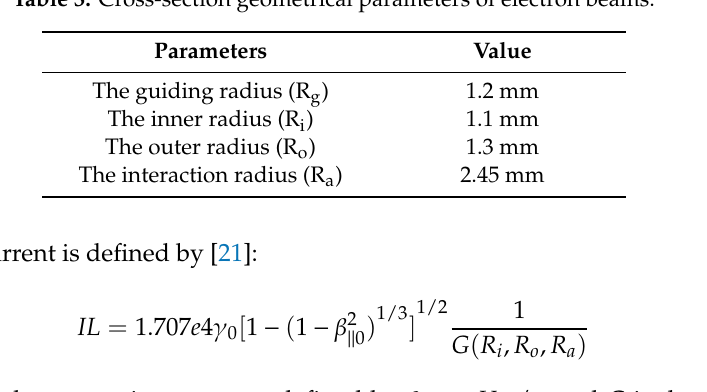
Table 3. Cross-section geometrical parameters of electron